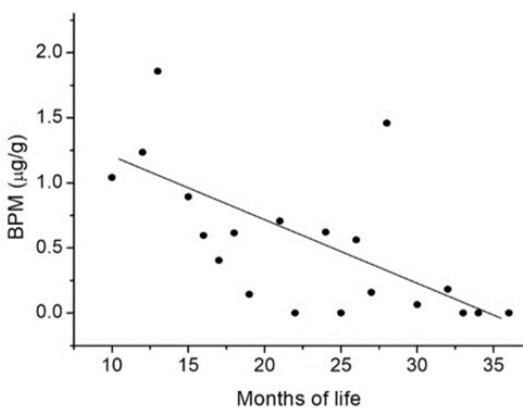
Figure 1. Graph showing the decline in average bisphenol M(BPM) concentrations (  g/g) ( y -axis) by